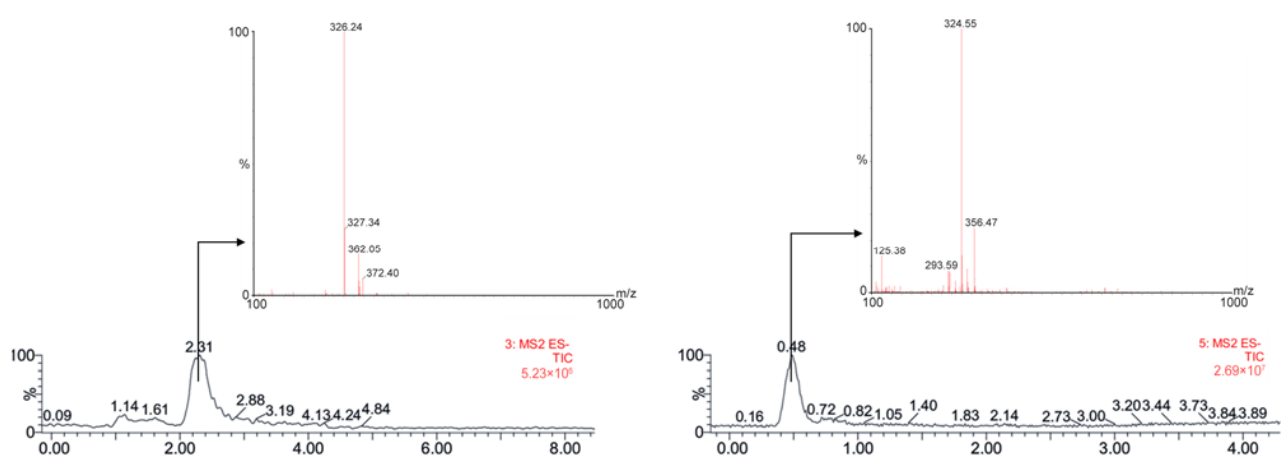
Figure 4. Full scans and mass spectra in the negative ion mode for synthesized NO 2 -OA ( right ) and NO 2 -LA ( left ) after purification.